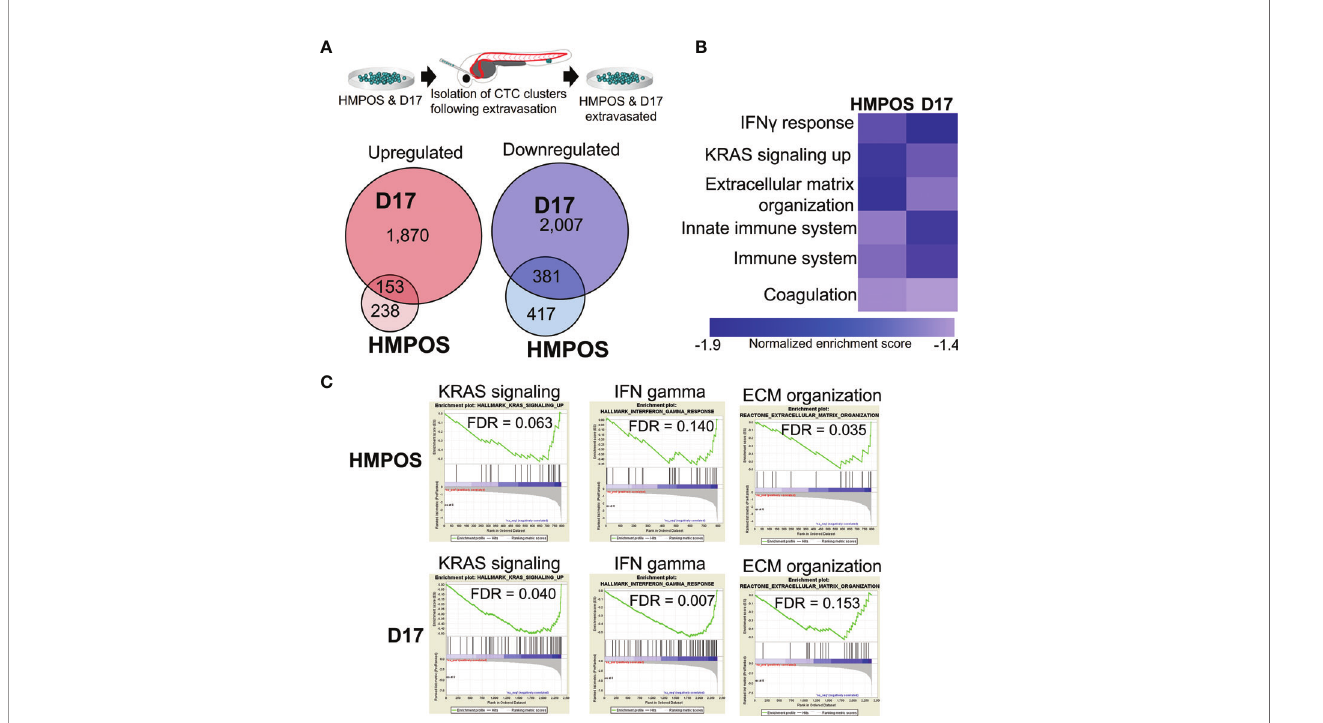
FIGURE 2 | Extravasated circulating tumor cells display differential expression of genes and pathways. (A) Overlaps in the upregulated and downregulated genes in extravasated circulating tumor cells. (B) Heat map of pathways commonly downregulated in extravasated circulating tumor cells. (C) Enrichment plots for KRAS signaling, IFN gamma response, and extracellular matrix (ECM) organization in HMPOS and D17 extravasated